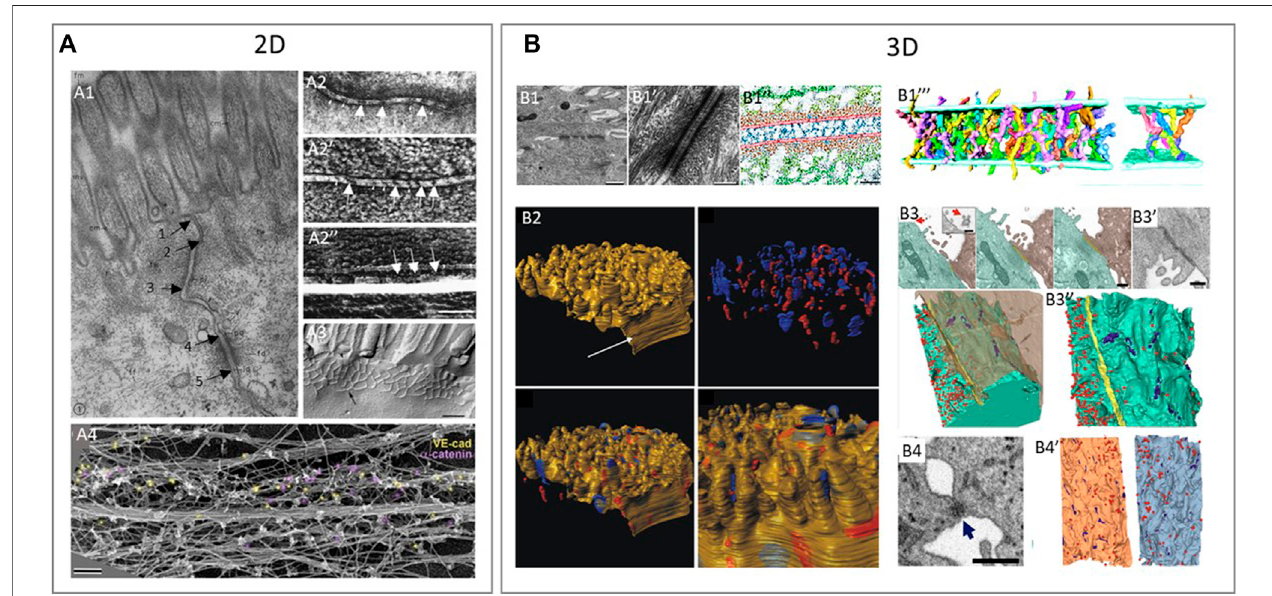
FIGURE 4 | Examples of using various 2D and 3D imaging techniques to study the structure of intercellular junctions. (A) 2D imaging techniques to study the structure of tight junctions, adherens junctions and desmosomes. (A1) : Transmission electron microscopy (TEM) shows a tight junction (arrow 1 – 2), adherens junction (arrow 2 – 3) and desmosome(arrow 4 – 5) in epithelium ofintestinal mucosa of rat(Farquhar and Palade, 1963). (A2) :Freezefractured EM(FFEM) ofepithelial junctions in which adherens junction is seen as a dense central structure between membranes (A2,A2 ’ ) and the underlying cytoplasmic actin bundles (A2 ’’ ) in retinal pigment epithelium (Miyaguchi 2000). (A3) : FFEM of tight junctions in mouse epithelial cells (Furuse 2010) A4: Platinum replica electron microscopy (PREM) is an EM based technique that allows researchers to image actin bundles next to junctions and in this study, researchers showed vascular-endothelial-cadherin (yellow) and α -catenin (purple) by immunogold labelling in relation to the actin cytoskeleton of linear endothelial adherens juctions (E fi mova and Svitkina, 2018). (B) 3D techniques to study the structure of tight junctions, adherens junctions and desmosomes. (B1) : Desmosomes between keratinocytes in neonatal mouse epidermis imaged by electron tomography(ET).ETimageofdesmosome (B1-B1 ’ ) and thecadherin moleculescrossingtheextracellular space(blueinB1 ’’ )inanannotatedimage.Reconstructionof individual cadherin molecules of a desmosome (B1 ’’’ ) (He et al., 2003). (B2) : 3D representation of a murine cardiac intercalated disc imaged by focused ion beam scanning EM(FIB-SEM). Desmosomes (blue) and gap junctions (red) in the intercalated discof murinecardiac muscle cells (Vanslembrouck et al., 2018). (B3,B4) : Tight junctions and desmosomes between SARS-CoV-2 virus infected cells (B3) and human lung epithelial cells (B4) imaged by FIB-SEM. (B3) : Two neighboring cells with a tight junction (yellow) at the contact site (B3) and a scanning EM (SEM) image of the tight junction seen as a dense structure between cells (B3 ’ ) . 3D reconstruction of neighboring cells seen in (B3) , with the tight junctions (yellow), small focal adhesions, likely desmosomes (purple) and virus particles (red) (B3 ’’ ) . (B4) : Desmosome-like junctionbetweenepithelialcellsimagedbySEMisvisibleasadenseshortstructureanda3Dreconstructionofneighboringcellsseenin (B4) withvirusparticles(red)and desmosome-like junctions (blue) (B4 ’ ) (Baena et al., 2021). Reproduced/adapted with